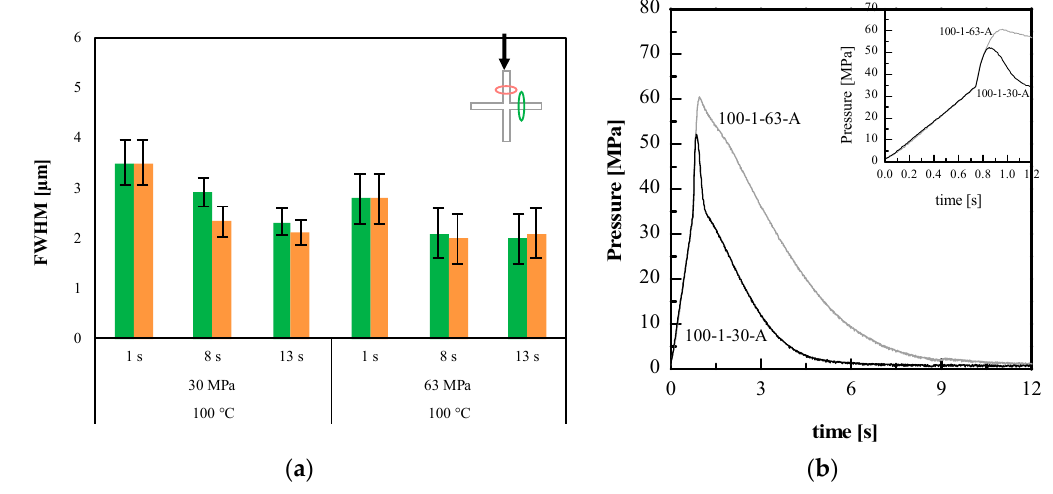
Figure 6. ( a ) FWHM index of micro-feature on PLA3251D samples obtained with different holding pressures and with T level = 100 °C, as indicated in Table 1. A sketch of the area where the AFM patterns have been acquired is also reported. ( b ) Pressure evolutions in position P2 obtained for the experiments 100-1-63-A and 100-1-30-A.